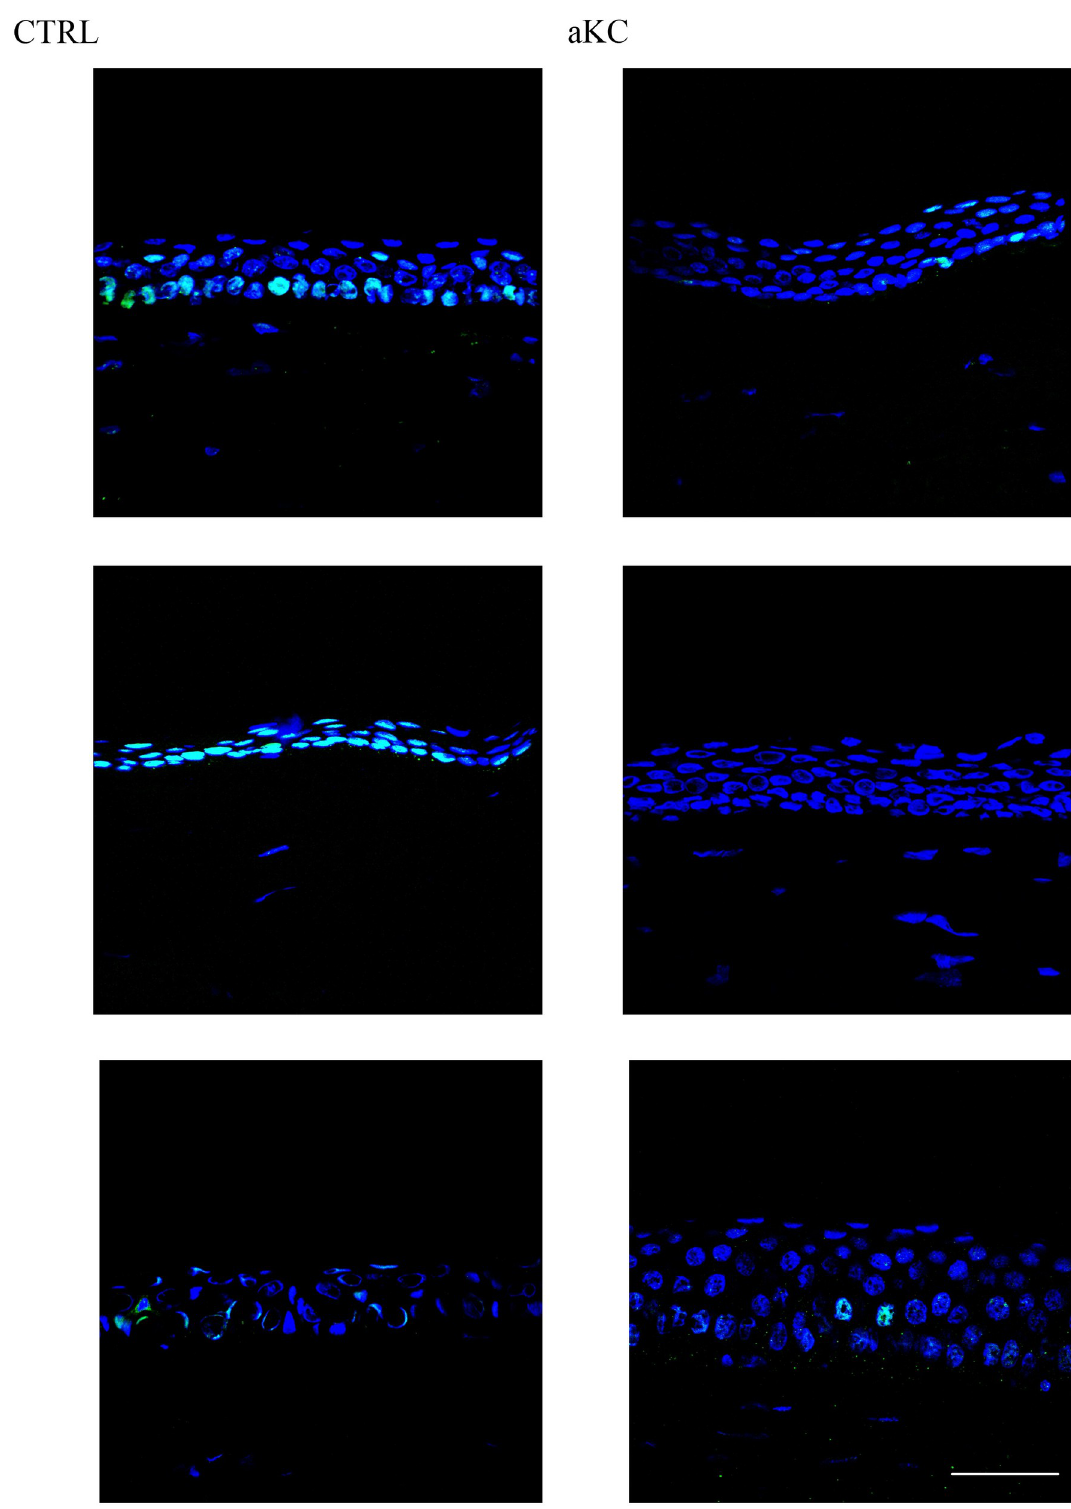
Fig 4. NRF2 active form staining in human corneal material. Sections of normal (CTRL; n = 5) and advanced keratoconus (KC; n = 3) corneas were analyzed by indirect immunofluorescence with an antibody targeting the active phosphorylated form of NRF2 (green). Nuclei were stained with TO-PRO Iodide (blue). Scale bar = 100 μ m. Figure show three representative controls and keratoconus. https://doi.org/10.1371/journal.pone.0273807.g004 PLOS ONE | https://doi.org/10.1371/journal.pone.0273807 October 14,